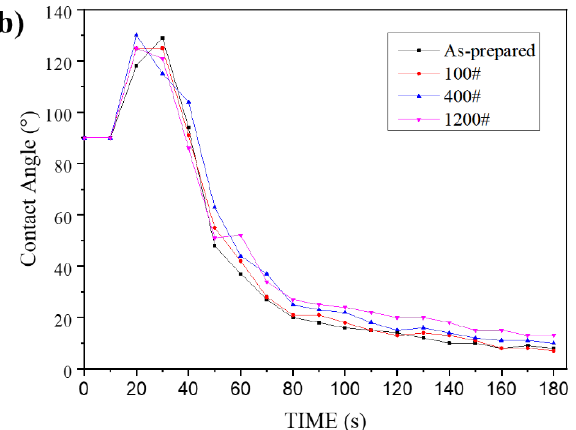
Figure 3. ( a ) Wetting process of the 7YSZ coatings with different roughness bond coats at 1250 ◦ C; ( b ) evolution of the contact angle over time.